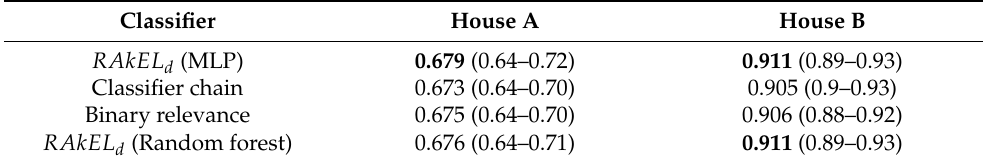
Table 6. Average F1 score per classifier trained on an unbalanced dataset. Inside the parentheses is the confidence interval (96% confidence). The best value can be seen in bold.